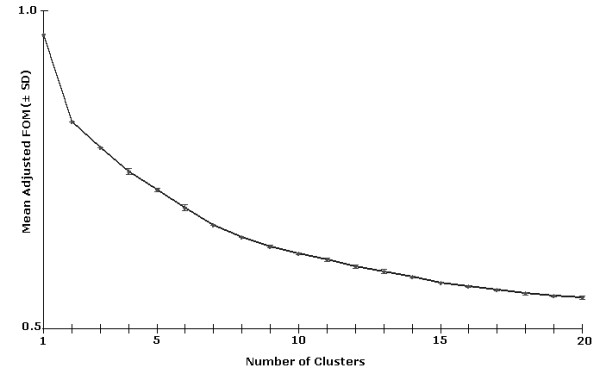
The mean values of 5-runs adjusted FOM calculations against the number of clusters. An open-source implementation of FOM provided by the Institute for Genomic Research (TIGR) [22] was used to calculate the adjusted FOM for k-means algorithm with Euclidean distance on normalised SAGE data. For a given tag, the abundance in each SAGE library was rescaled to make the sum of tag counts across all 14 libraries equal to one.